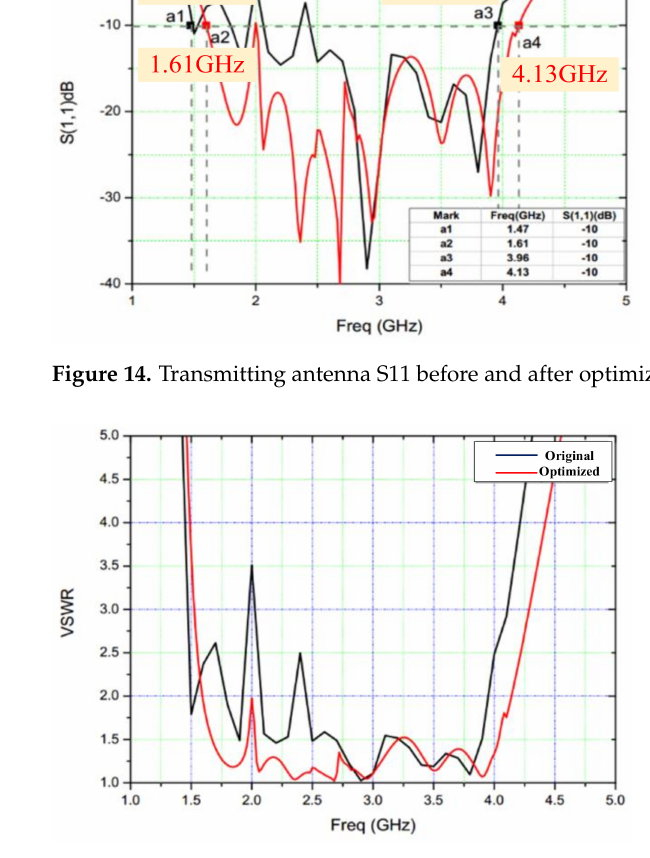
Figure 15. Transmitting antenna VSWR before and after optimization.